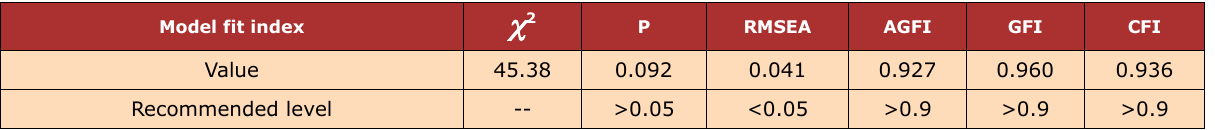
Table 4. Goodness-of-fit